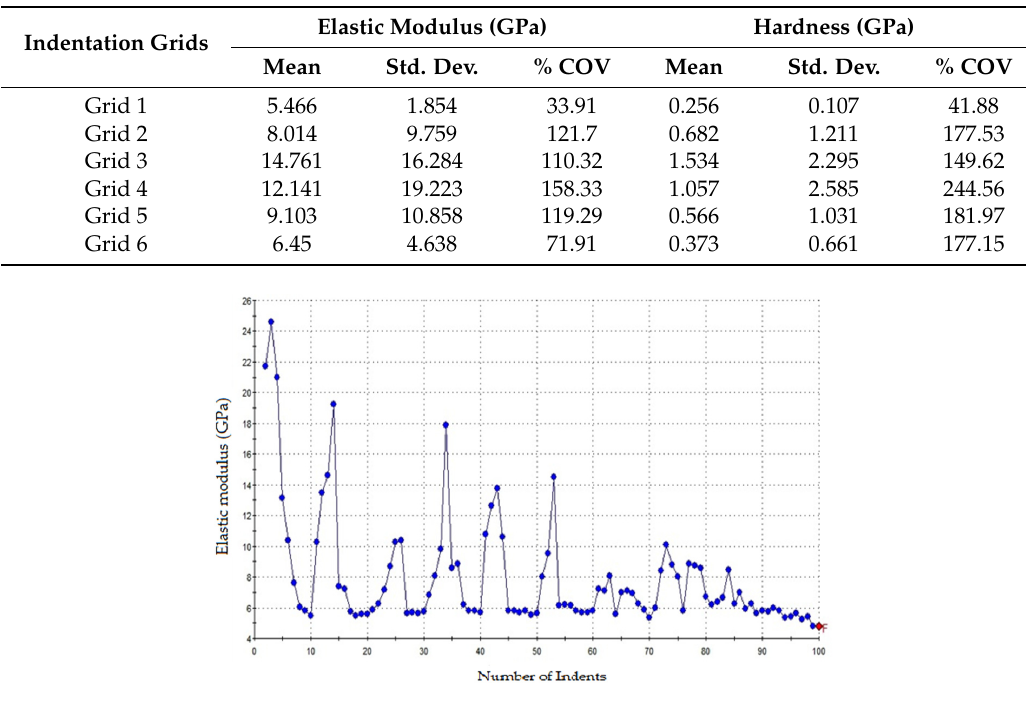
Figure 8. Variation of elastic modulus with the number of indents on the coating (300 m).